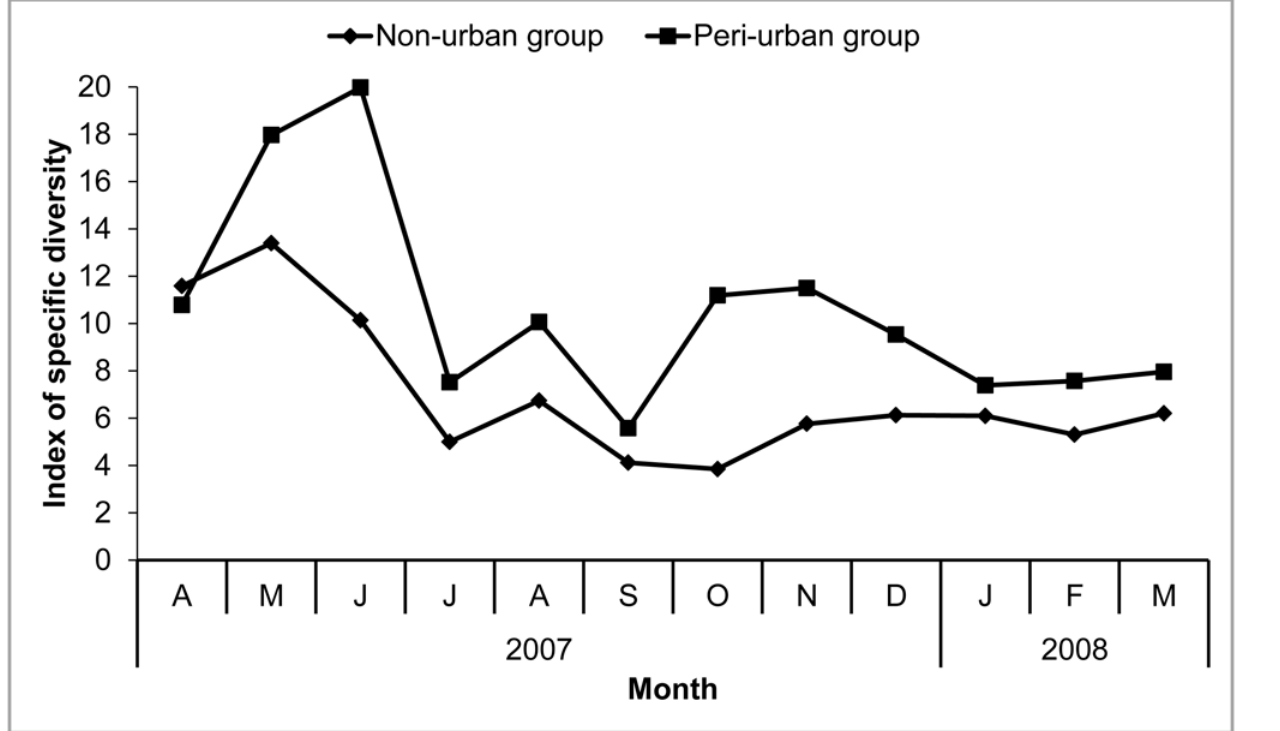
Fig 4. Monthly variation in the specific diversity of the macaques ’ diets in the two peri-urban and non-urban